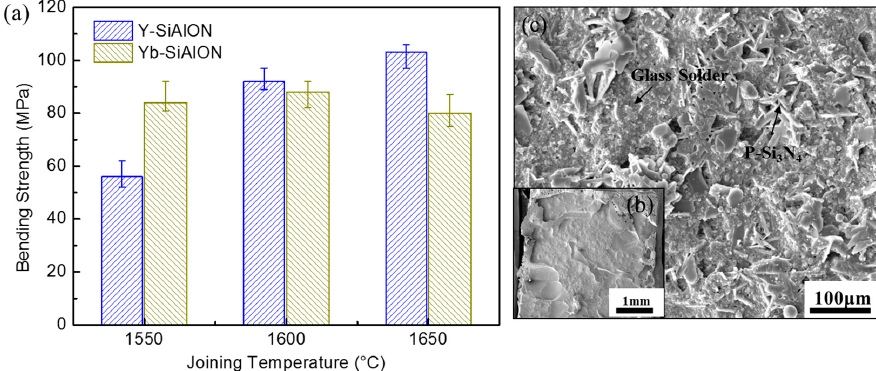
Figure 5. The function of the bending strength of the P-Si 3 N 4 /D-Si 3 N 4 joints as bonding temperatures ( a ), the fracture surface of the joint bonded with Y-SiAlON at 1650 °C ( b ), and the magnified micrograph of the fracture surface ( c ).